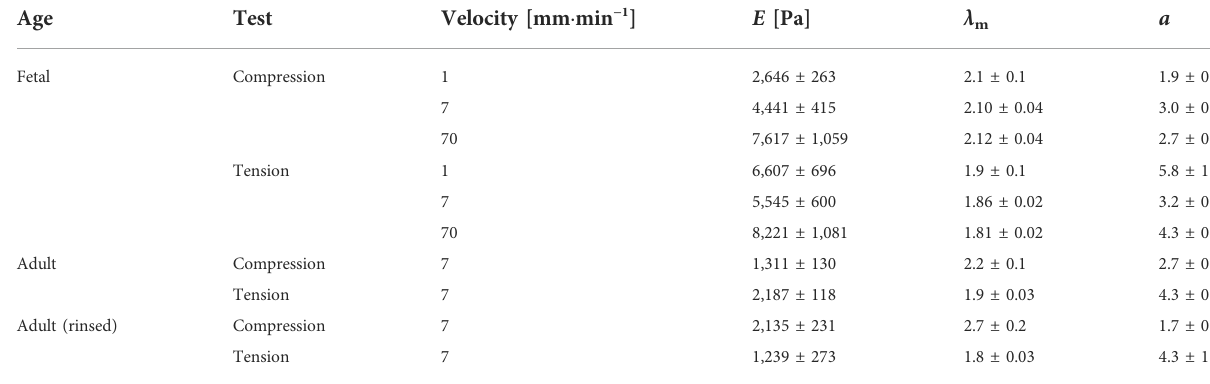
TABLE 1 Mean parameters with standard error derived from the van der Waals model of the best fi ts to the experimental data for the respective lung samplesatdifferentvelocities.Here, E istheYoung ’ smodulus, λ m isthemaximumstrain,and α istheparameterdescribingtheglobalinteractions within the network. Adult (rinsed) refers to the adult lung without